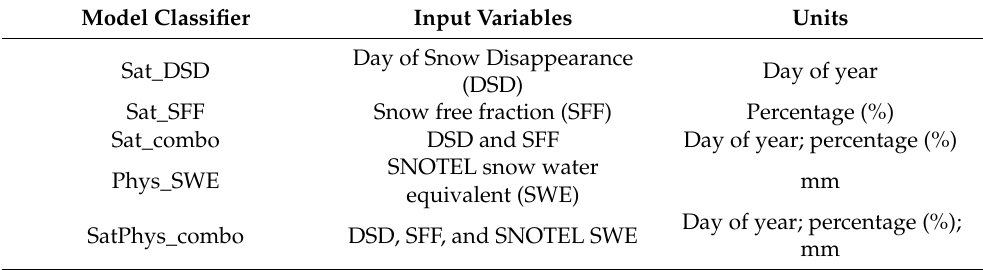
Table 2. Description of model inputs, units, and naming scheme. ‘Sat’ describes satellite-based measurements of snow, whereas ‘Phys’ refers to physical, in situ